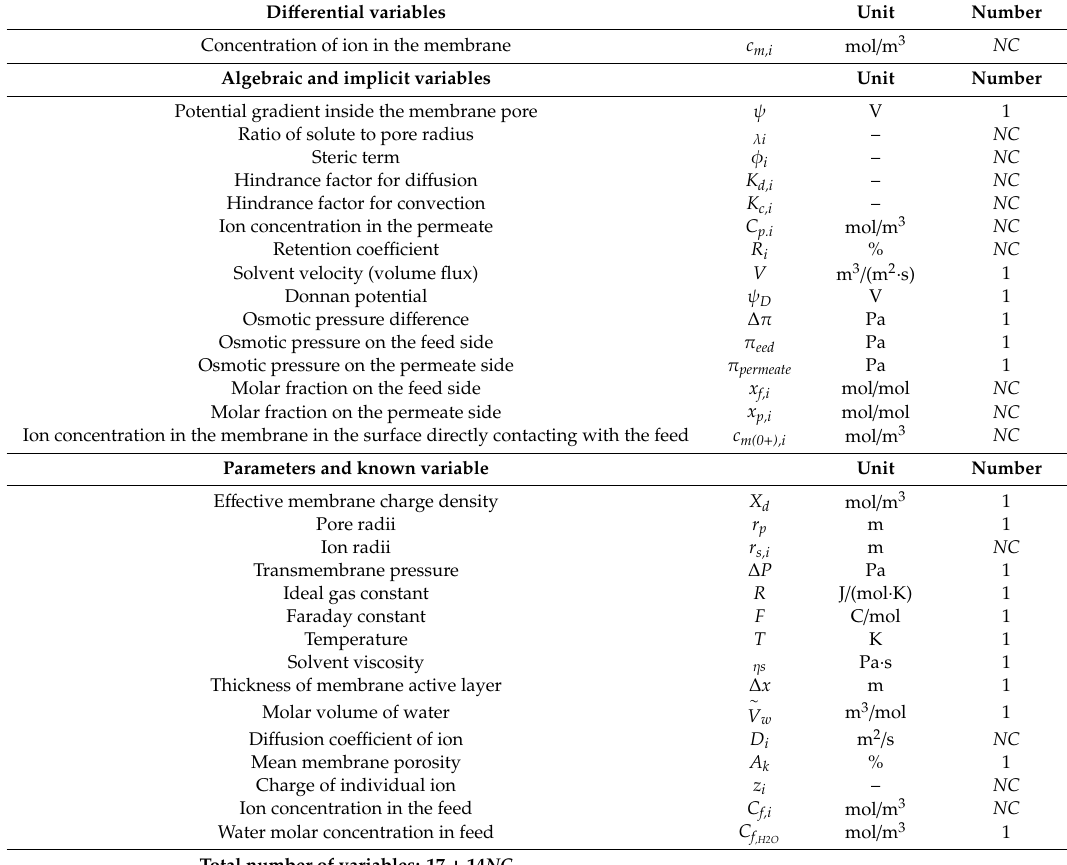
Table 2. Variables in the ddDSPM model ( NC —number of separated